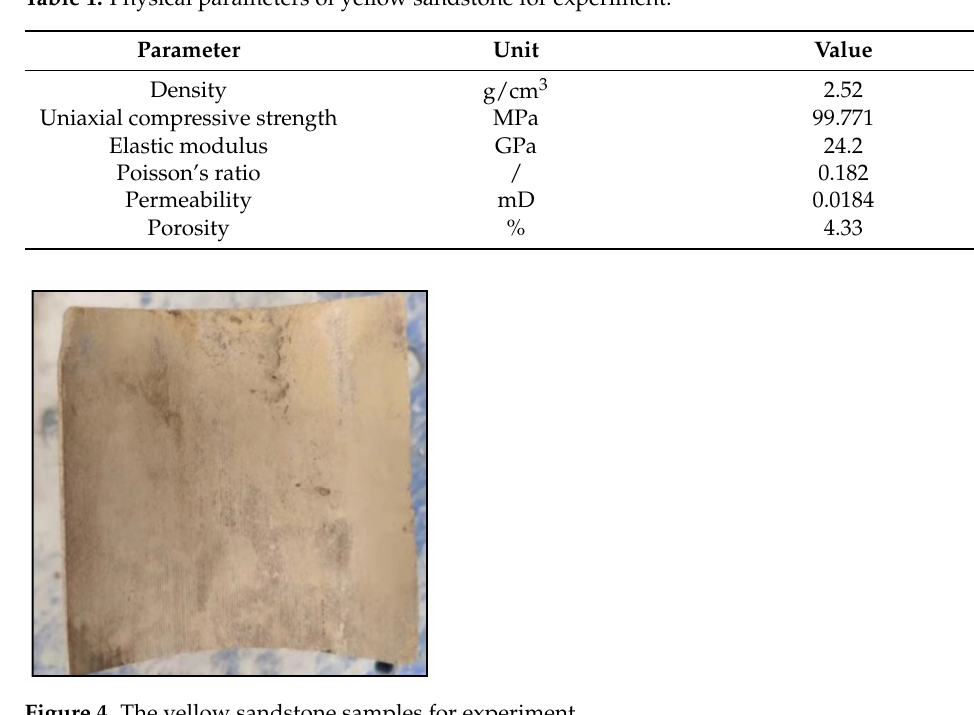
Figure 3. Experiment screen tube and internal conditions. Table 1. Physical parameters of yellow sandstone for experiment.